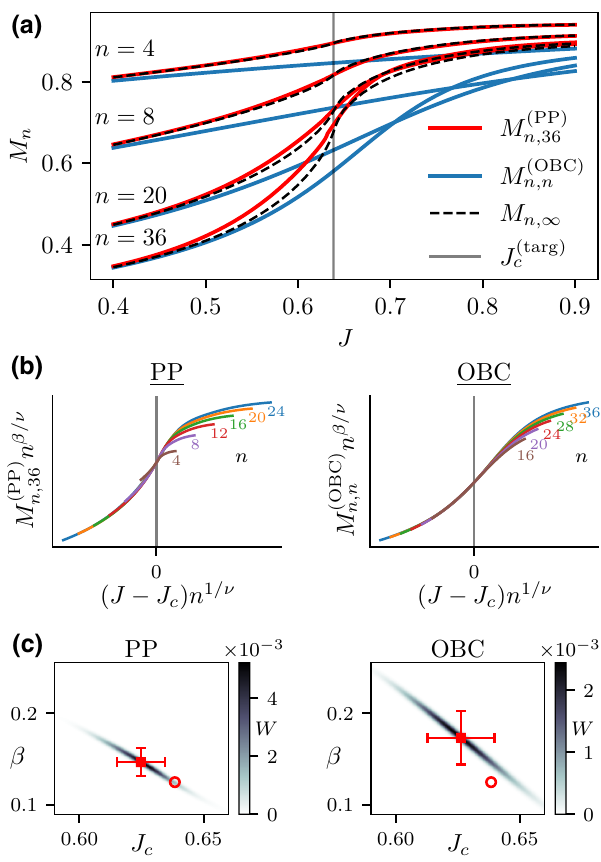
FIG. 8. (a) Root-mean-square staggered magnetization, Eq. (19), for several subsystem sizes n obtained from the OBC GS ), from the PP states ( M ( PP ) ), and from the reduced states ( M ( OBC ) n , n n , N of the infinite system ( M n , ∞ ), see the text. The gray solid vertical ( targ ) line indicates the critical point J c numerically estimated by applying fine-size scaling (FSS) analysis to infinite MPS (IMPS) states obtained by the IDMRG approach. (b) Curves of the mag- netization fitted to the scaling hypothesis, Eq. (20), for the case N = 36 and the average values ( J c , β) obtained from the likeli- hood distribution in (c). The numbers give the subsystem sizes n for the curves with the corresponding colors. (c) Likelihood distribution W ( J c , β) . The red cross indicates the average values of ( J c , β) with corresponding standard error. The purple marker ( targ ) β ( targ ) = 1 / 8 ) points the target values of ( J c ,